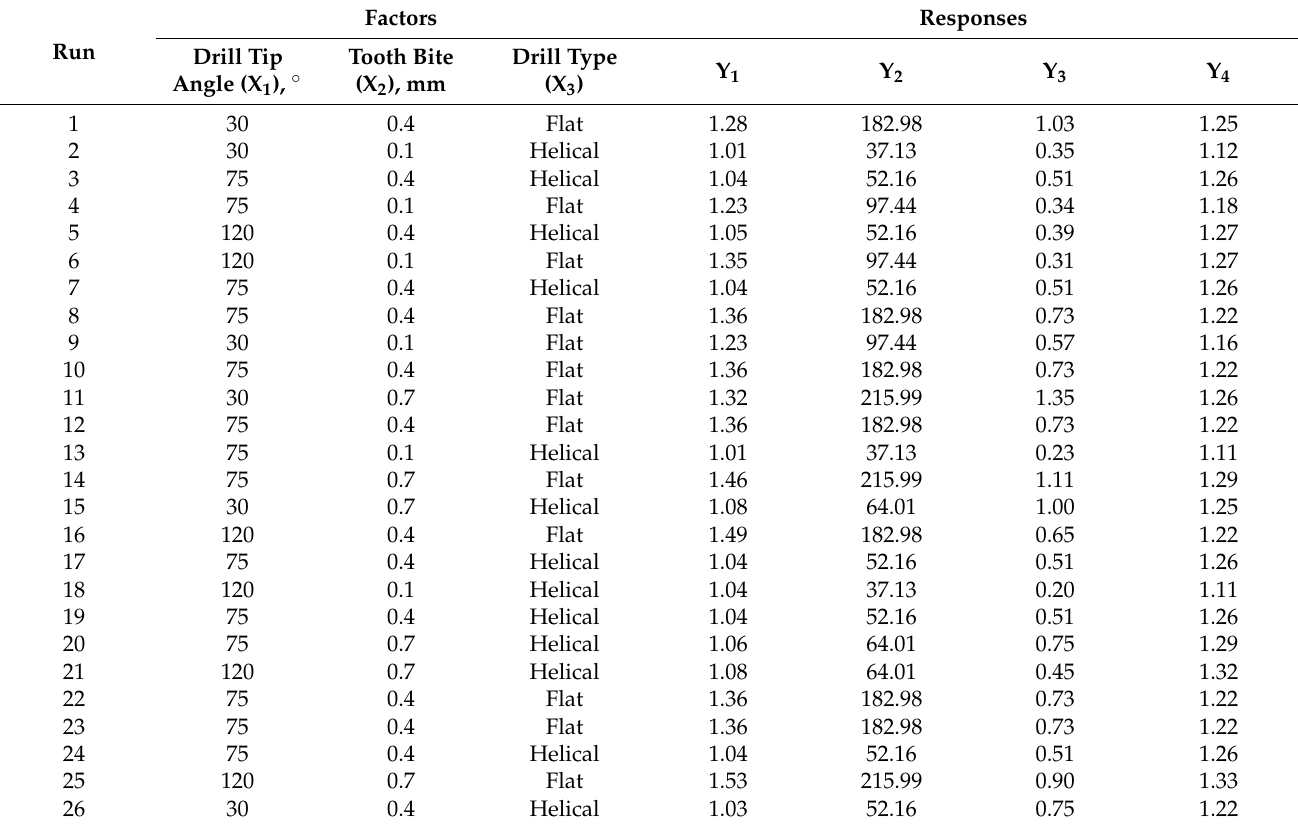
Table 3. Combinations among selected factors and the value of analyzed